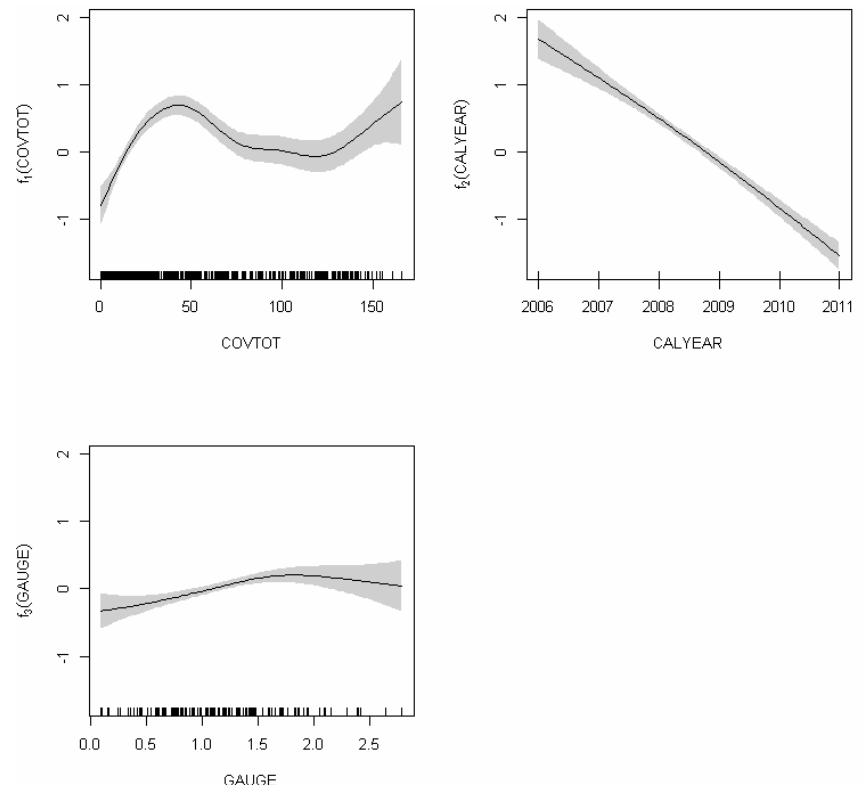
1100 Fig. 5. Nonlinear effects of the total degree of coverage (COVTOT), calendar year (CALYEAR), and groundwater level (GAUGE) on the Figure 5 1101 proportion of herbaceous plants (PROPHERB) (see Eq. 12). Shaded: 95%-confidence area. Table 8. Parameter estimates and significances for the model estimating the proportion of herbaceous plants (PROPHERB) as shown